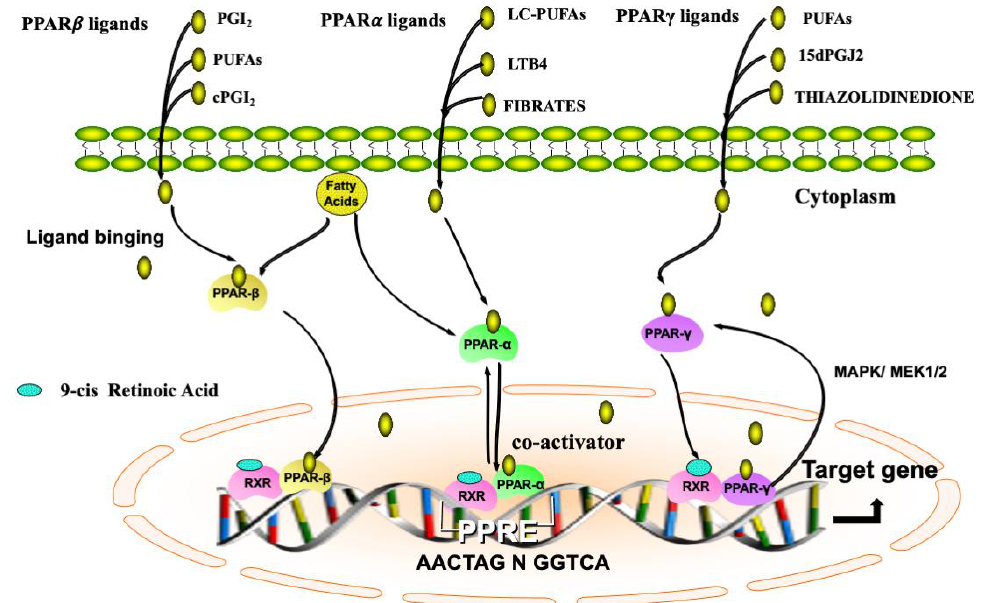
Figure 1. Illustrative representation of localization and mechanism of action of PPARs. PPARs belong to the nuclear receptor superfamily and consist of PPAR α , PPAR β / δ , and PPAR γ . Endogenous PPAR ligands can be transferred from the cytosol or generated in the nuclear membrane. PPARs bind to the specific DNA sequence AACT AGGNCA A AGGTCA, PPAR responsive element (PPRE), and their activation requires heterodimerization with another nuclear receptor, RXR. PPARs modulate numerous target genes by co-activator or co-inhibitor activity. PPARs are mainly expressed in the nucleus, and could shuttle from nuclear to cytoplasm. PPAR γ transport from nuclear to cytoplasmic occurs via the extracellular signal-regulated kinase (ERK) cascade, a component of the mitogen-activated protein kinase (MAPK)/MEK 1/2. PPARs, peroxisome proliferator-activated receptors; RXR, 9-cis retinoic acid receptor.